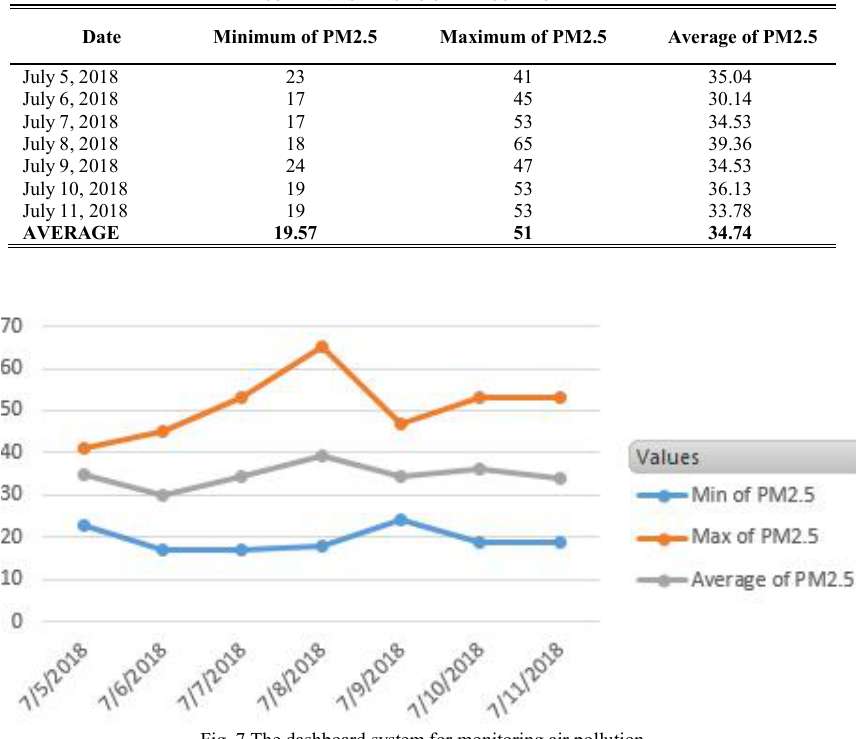
Fig. 7 The dashboard system for monitoring air